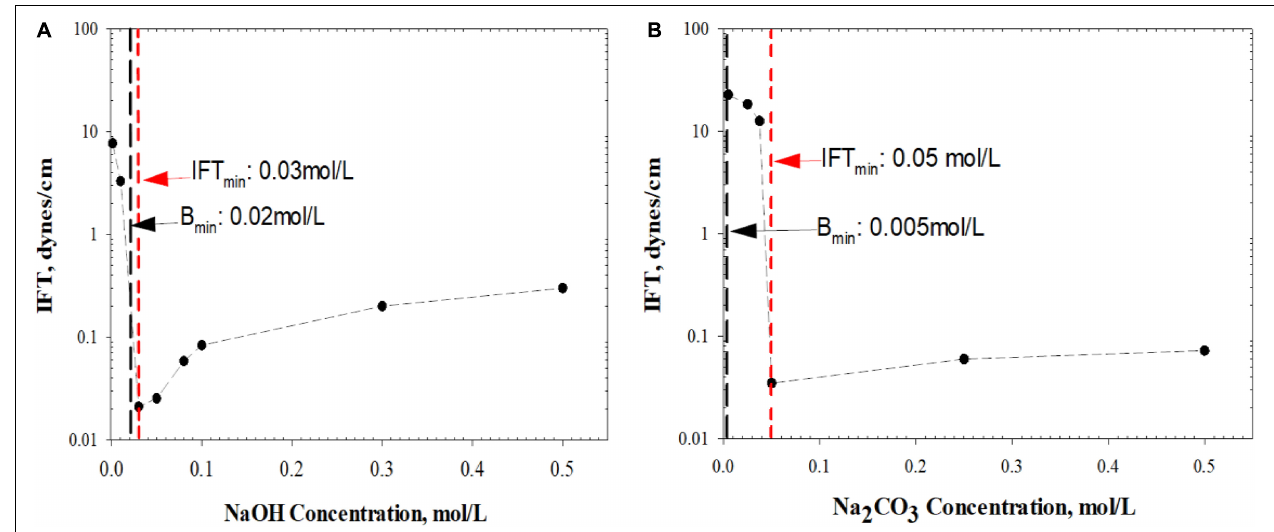
FIGURE 15 | IFT change with increasing (A) NaOH concentration and (B) Na 2 CO 3 concentration. B min : the optimum concentration of bottle test; IFT min : the concentration induces minimum IFT.